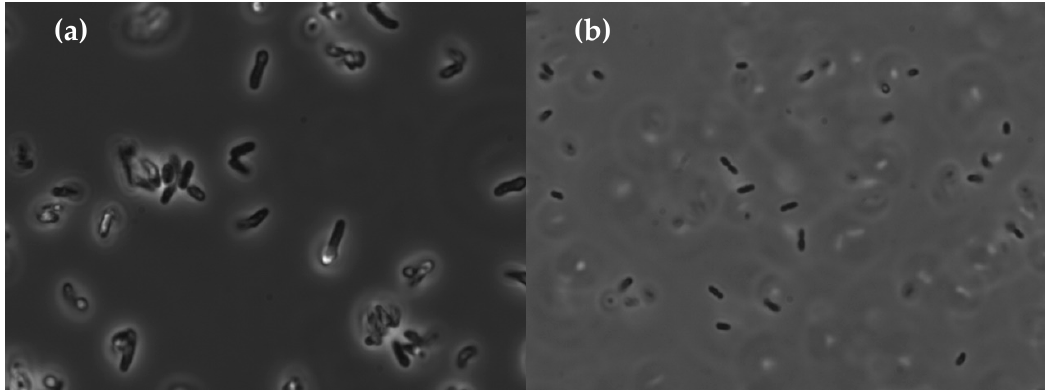
Figure 6. Gram staining of ( a ) Rhodococcus rhodochrous, and ( b ) Ochrobactrum anthropi.